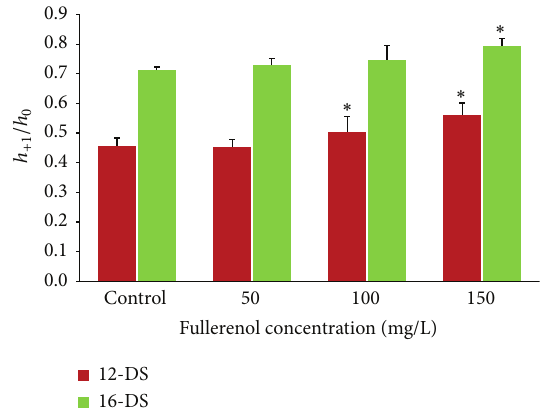
Figure 5: The influence of fullerenol on the membrane fluidity of erythrocyte membrane labeled with 12-DS and 16-DS. Erythrocytes were incubated with fullerenol at 50, 100, and 150mg/L for 3 h at 37 ∘ C. Control: erythrocytes incubated without fullerenol. Bars are mean ± SD for five independent samples. ∗ values statistically different in comparison with control values, 𝑃 < 0.05